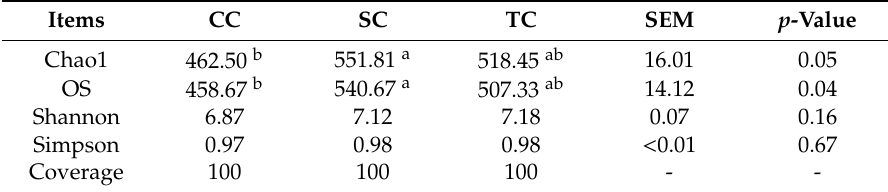
Table 4. Alpha diversity analysis of the cecal microbiota of broilers.